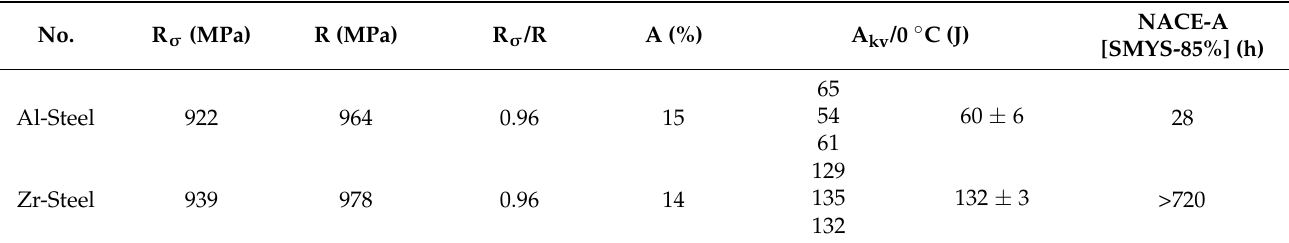
Table 3. Mechanical properties of experimental steel.